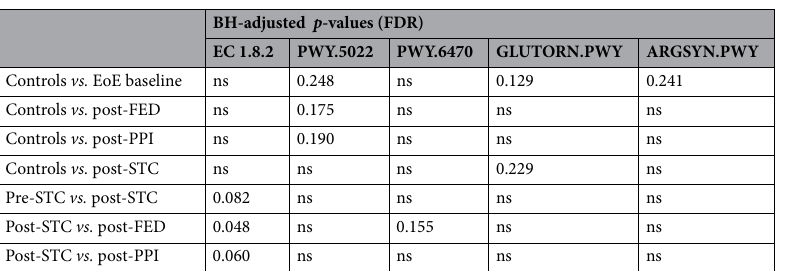
Table 3. Differential abundance testing for predicted metabolic content and pathways. Only reactions (Enzyme Commision number; EC) and pathways (PWY) with at least one significant difference between groups according to adjusted p < 0.1 and p < 0.25 (Benjamini–Hochberg correction), respectively, are shown. BH: Benjamini–Hochberg correction; FDR: false discovery rate; EC 1.8.2: sulphur-cytochrome oxidoreductases; PWY.5022: 4-aminobutanoate degradation; PWY.6470: peptidoglycan biosynthesis V (β-lactam resistance); GLUTORN.PWY: L-ornithine biosynthesis I; ARGSYN.PWY: L-arginine biosynthesis II; EoE: eosinophilic oesophagitis; FED: food-elimination diet; PPI: proton pump inhibitors; STC: swallowed topical corticosteroids; ns: not significant ( p > 0.1 for EC and p > 0.25 for PWY).